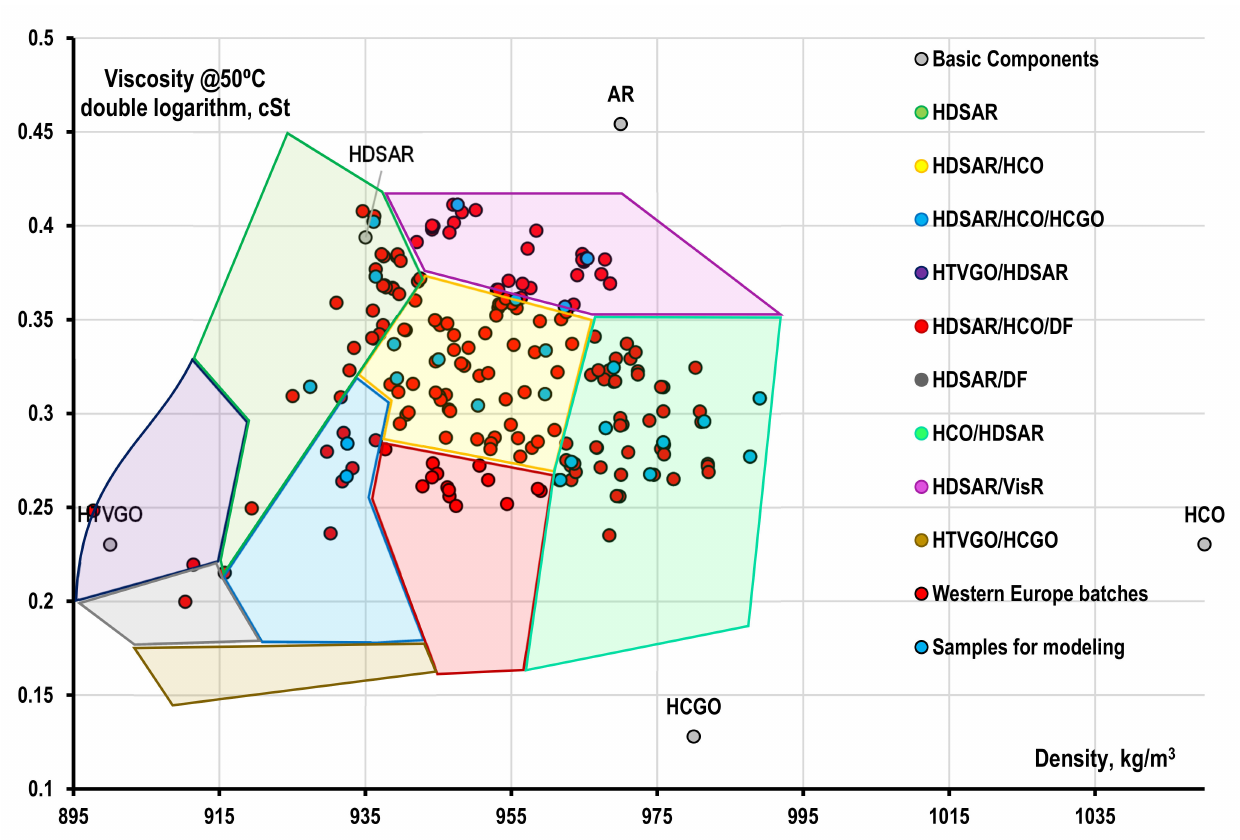
Figure 24. RME 180 batches in logarithmic coordinates